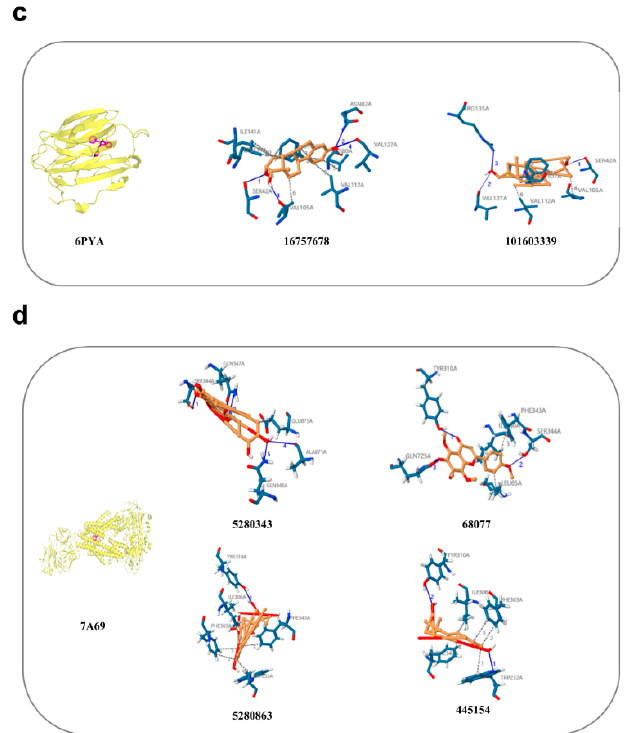
Figure 11. Molecular docking of the hub genes with its corresponding compounds. ( a ) NOS2 , ( b ) SLC6A4 , ( c ) SHBG , ( d ) ABCB1. The number indicates the PubChem ID.